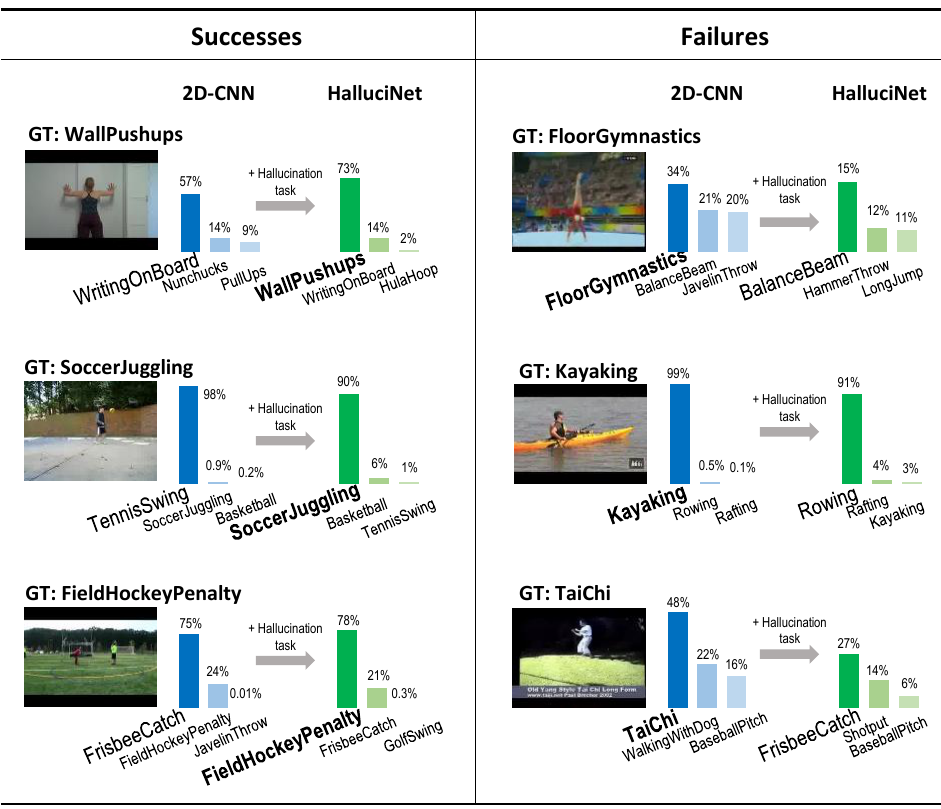
Figure 2. Qualitative results. The hallucination task helps improve performance when the action sample is visually similar to other action classes, and a motion cue is needed to distinguish them.